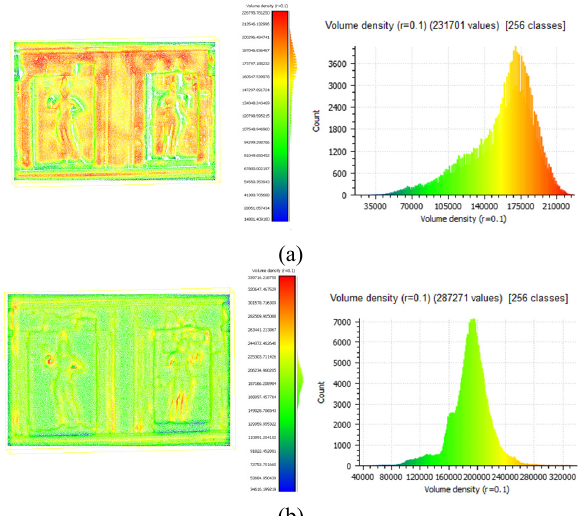
Figure 6. Density analysis for the carvings of Figure 5: (a) density of TLS data and (b) density of photogrammetry